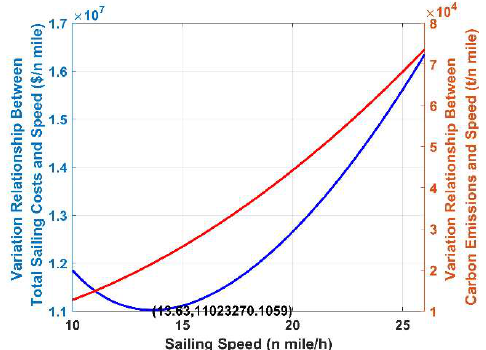
Figure 4. Relationship diagram of dual objectives and speed.